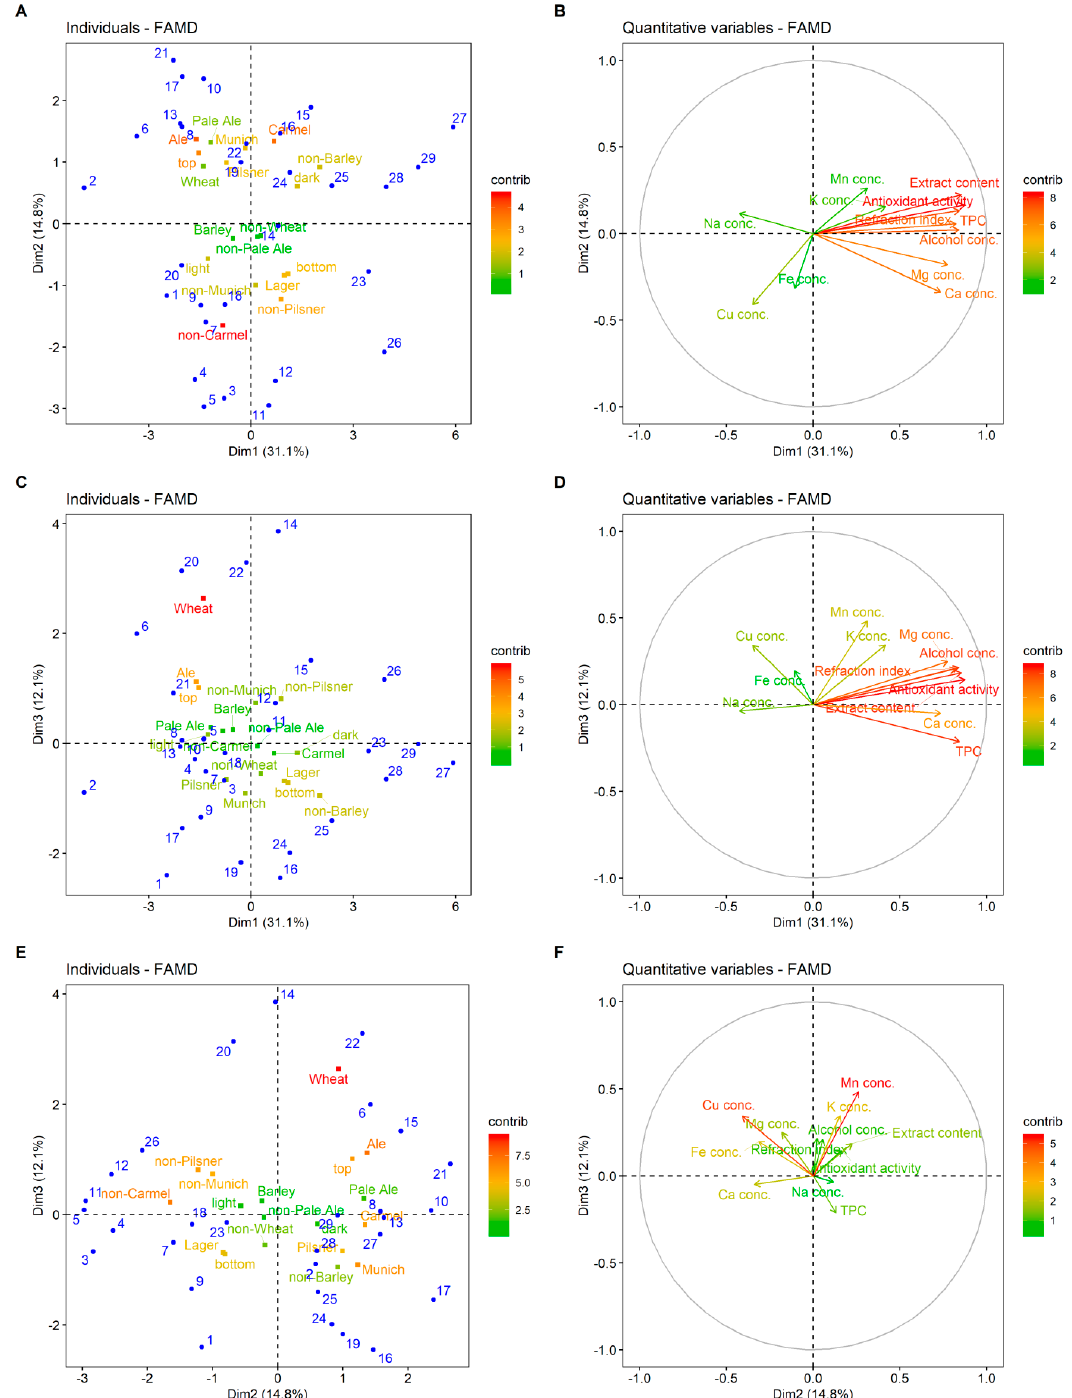
Figure 2. Factor maps for the first three dimensions (factors) obtained from the factor analysis of mixed data. ( A , C , E) : Individual (different beers listed in Table 2) in blue and qualitative variable categories colored according to their contribution to dimensions. ( B , D , F) : Quantitative variables colored according to their contribution to dimensions.